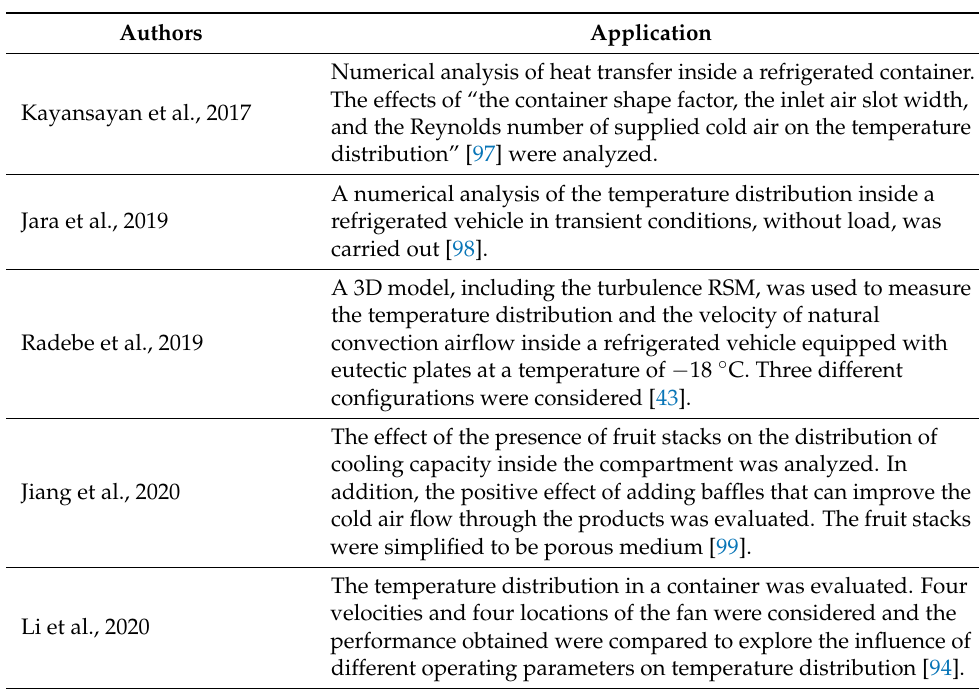
Table 18. Summary of recent studies on the temperature distribution inside refrigerated vehicle through CFD